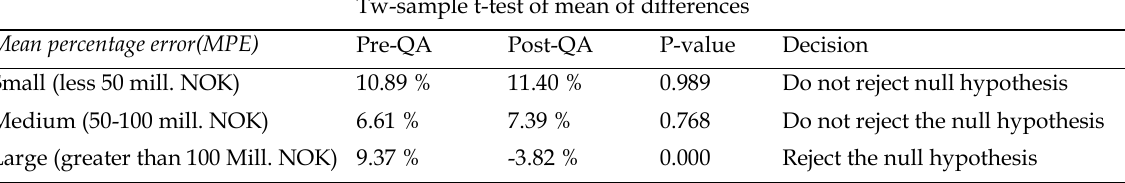
Table 5. Testing for the significance of differences in PCO between pre- and post-quality assurance for all project